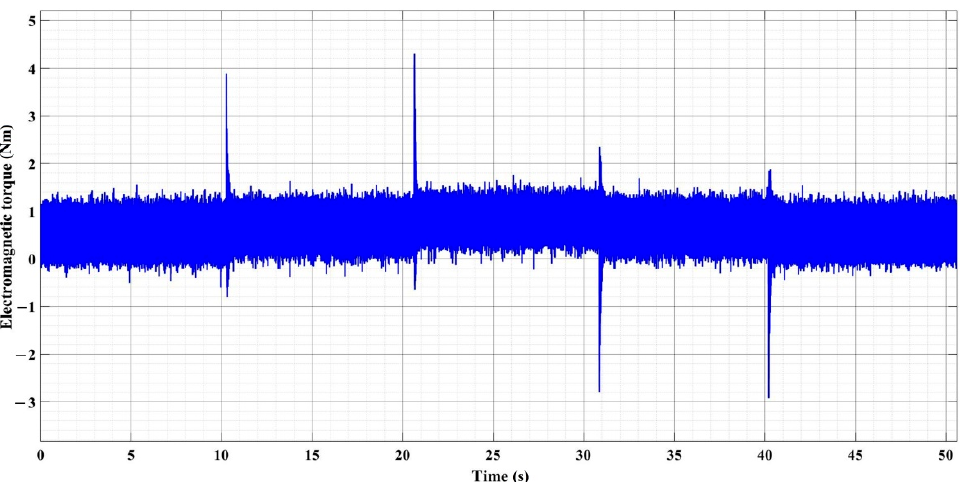
Figure 39. Real-time evolution for i q current—HIL stage; T L = 1 Nm.